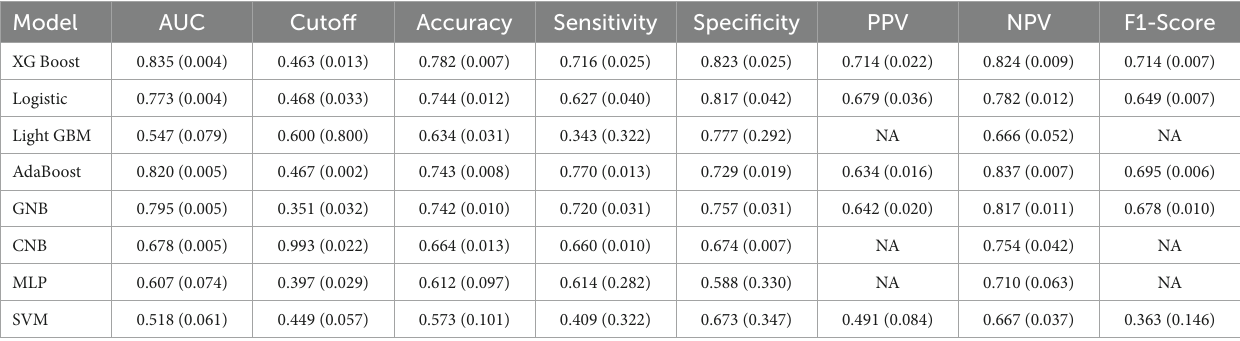
Data are shown as means ± standard deviations (SD). AUC, area under the receiver operating characteristic curve; PPV, positive prediction value; NPV, negative prediction value; GNB, Gaussian Naïve Bayes; CNB, Complement Naive Bayes; GNB, Gaussian Naïve Bayes; MLP, multi-layer perceptron neural network; SVM, support vector machine; NA, not